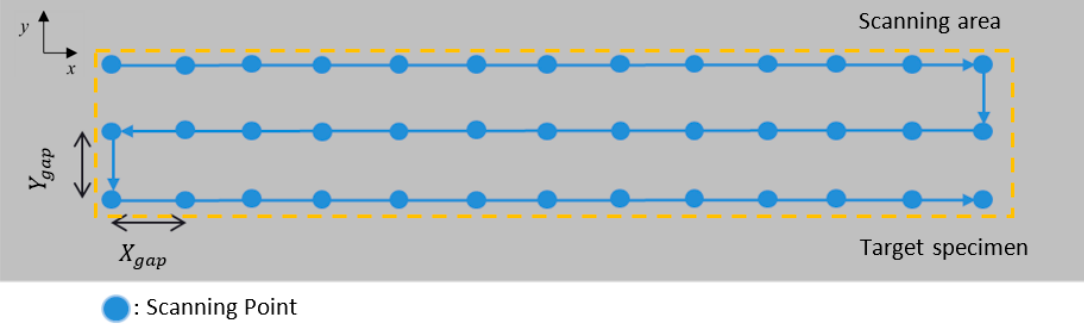
Figure 2. Illustration of the synchronized scanning for both through transmission and pitch-catch configurations.